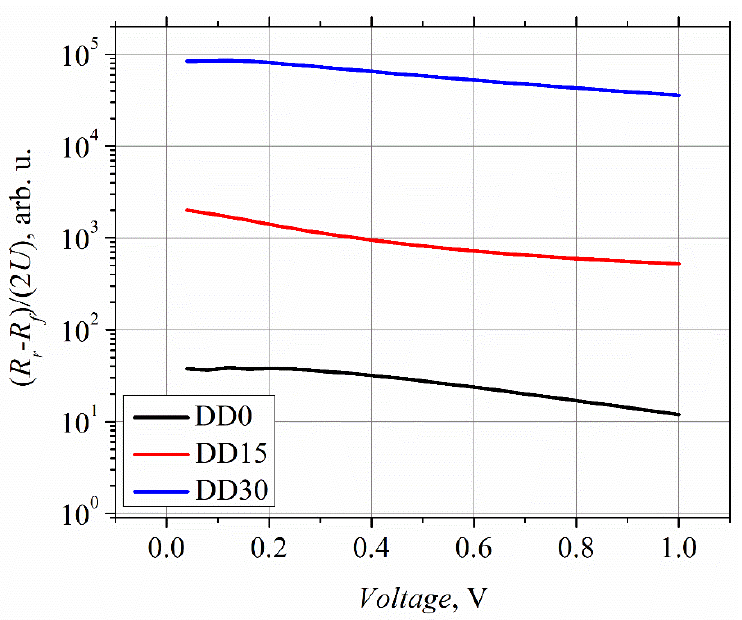
Figure 5. Dependence of the IV asymmetry of the planar microwave diodes on applied bias volt-